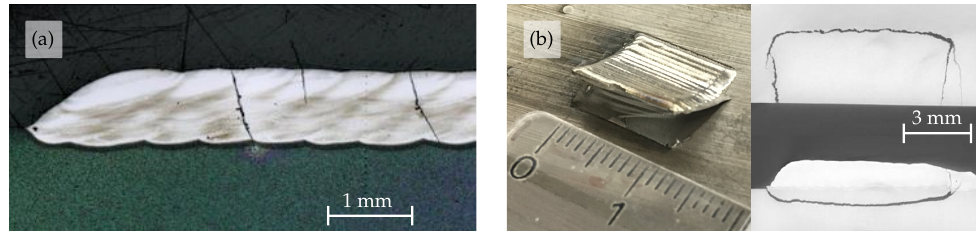
Figure 2. ( a ) Crack formation in the weld metal. ( b ) Crack formation in the